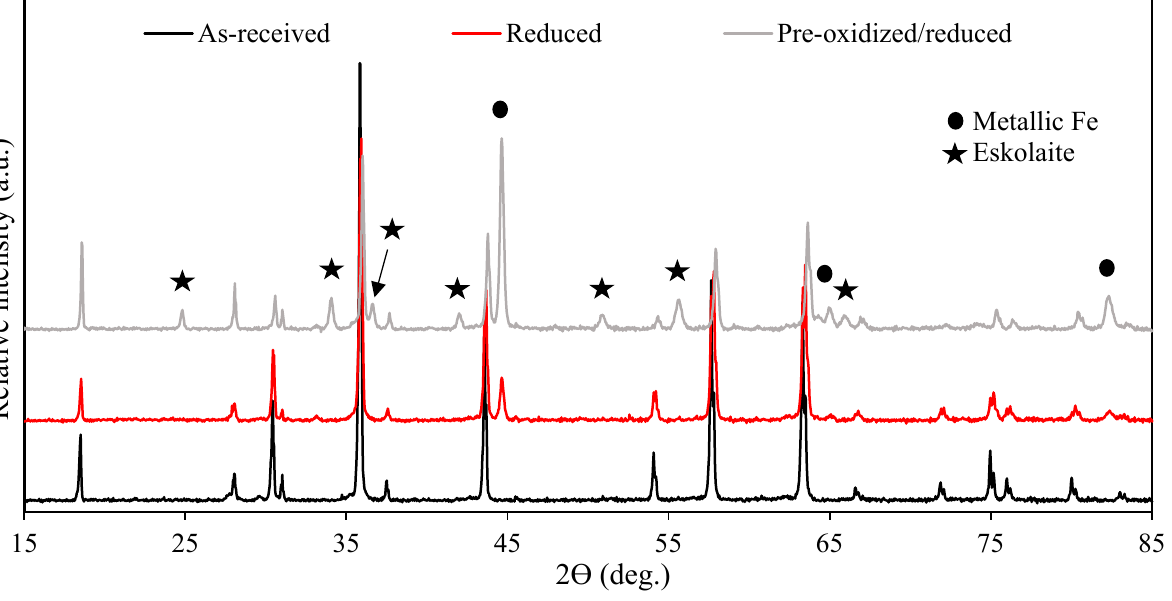
Figure 9. XRD patterns of the as-received chromite ore, samples reduced at 750 mL/min hydrogen flow rates, and samples pre-oxidized (1100 °C for 60 min) and reduced (1100 °C at a 750 mL/min hydrogen flow rate for 60 min).